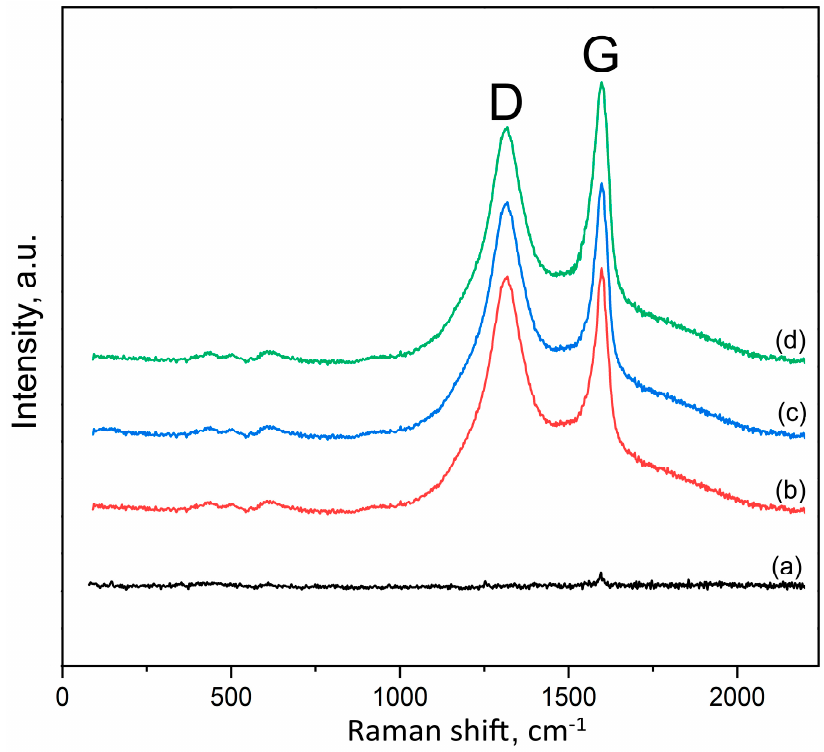
Figure 7. Raman spectra of the 0GO ( a ), 0.1GO ( b ), 0.3GO ( c ), and 0.5GO ( d ) samples after MAO treatment. “D” and “G” denote GO peaks.